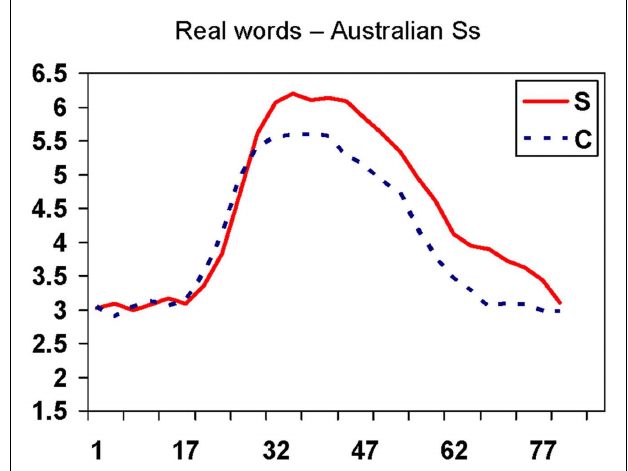
FIGURE 1 | Real words rated by native English-speaking listeners: mean rated goodness as /s/ on a 7-step scale (vertical axis) as a function of step on the 81-step continuum from /z/ at left through /s/ to / ∫ / at right (horizontal axis), separately for words spelled with S (solid line) and C (dashed line).